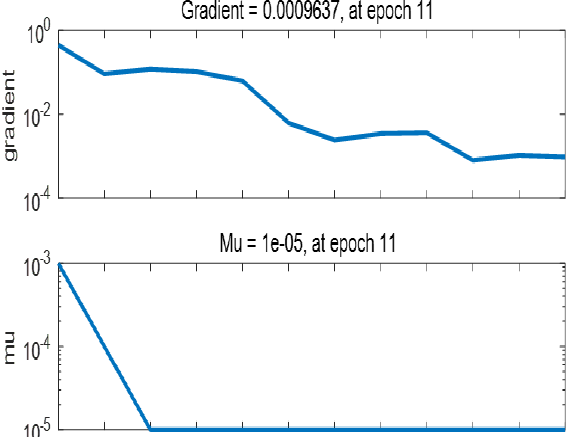
Figure 16. Gradient curve chart.